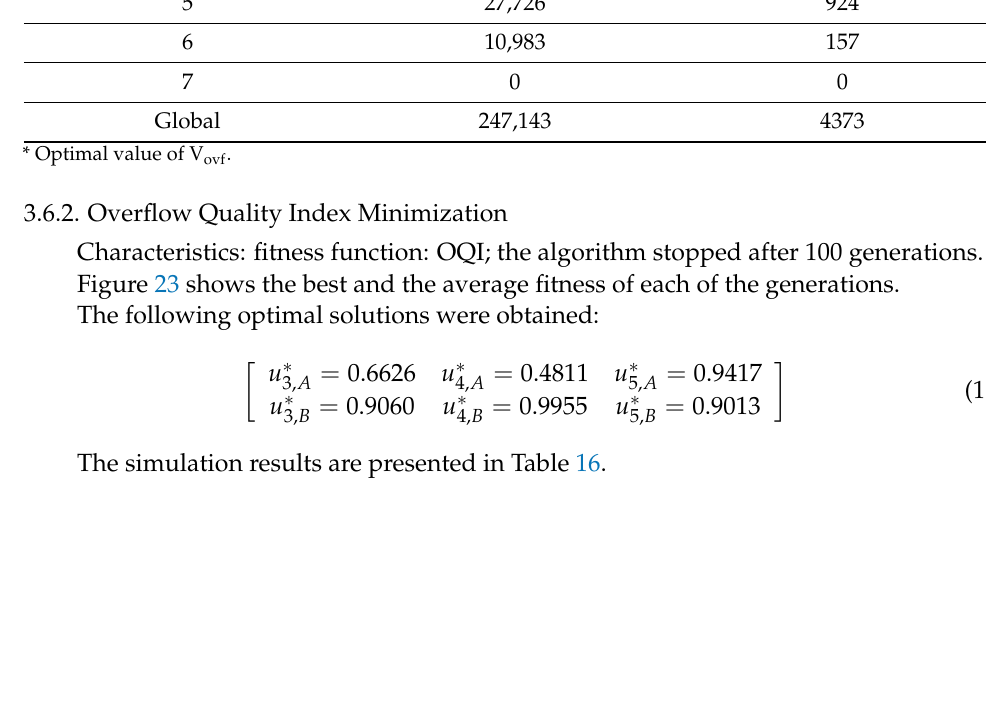
Table 15. Simulation results when the volume of overflow is minimized (strategy #5). Tank Number